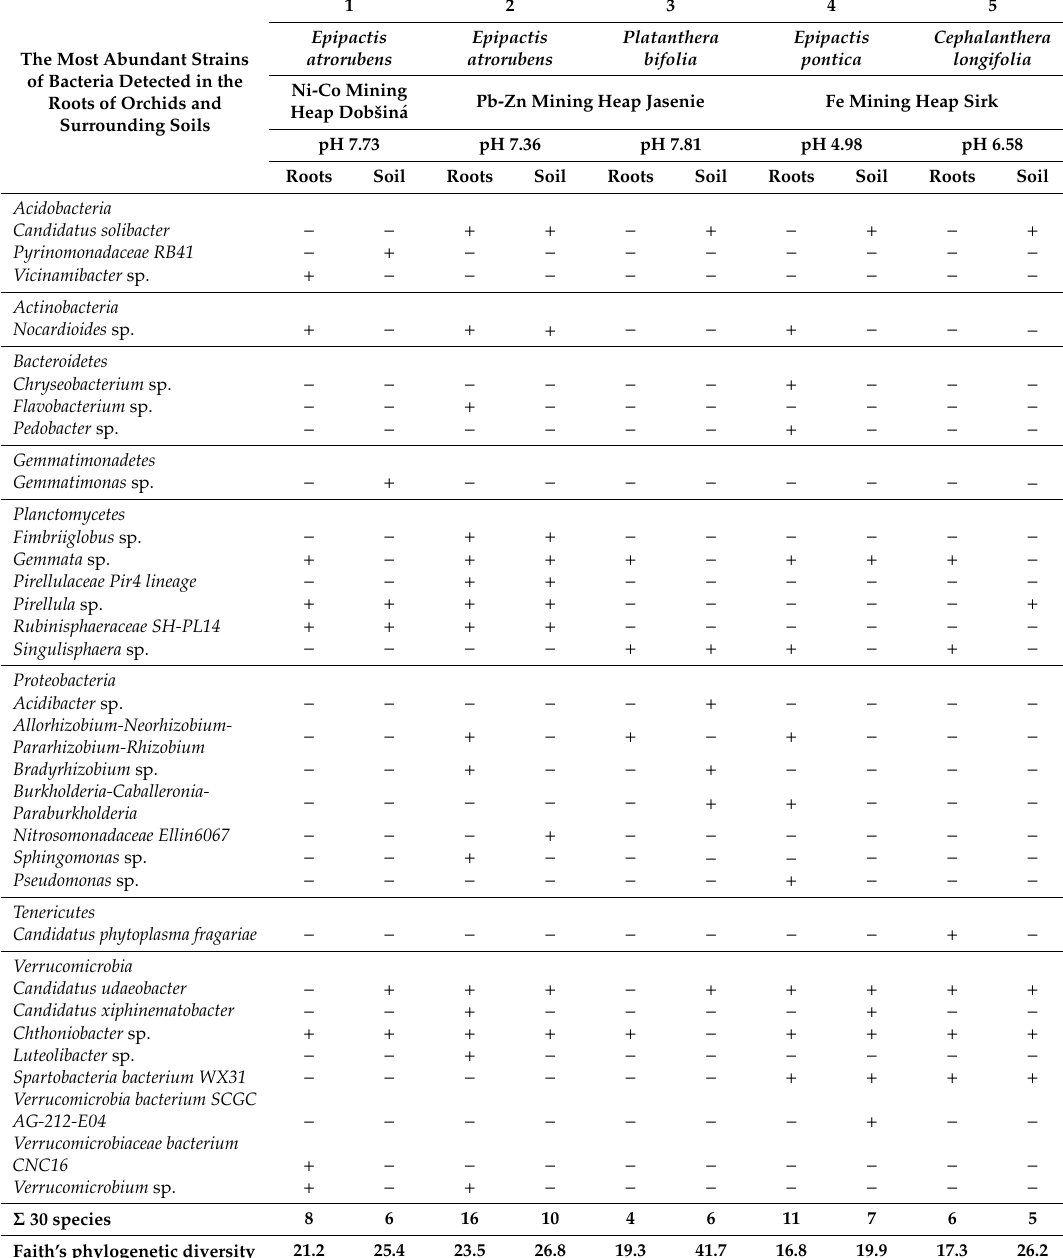
Table 2. DNA identification of the bacteria isolated from the roots of the orchids and surrounding